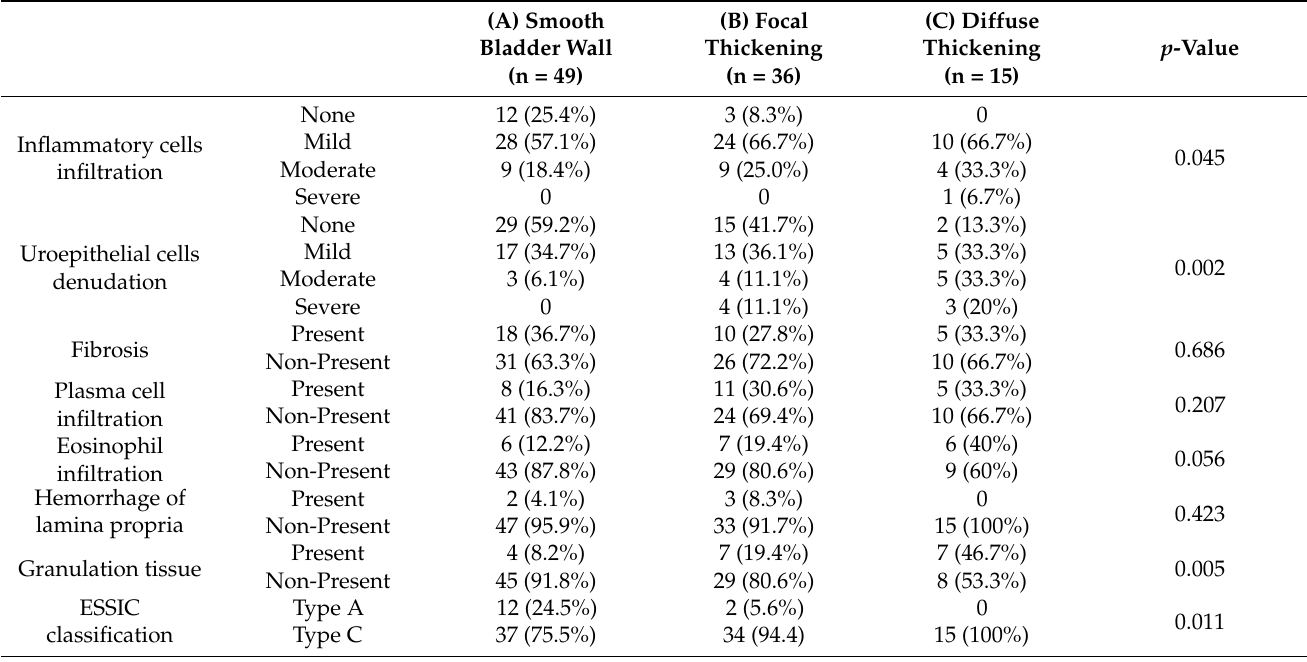
Table 2. Bladder wall thickness and histopathological findings in patients with interstitial cystitis/bladder pain